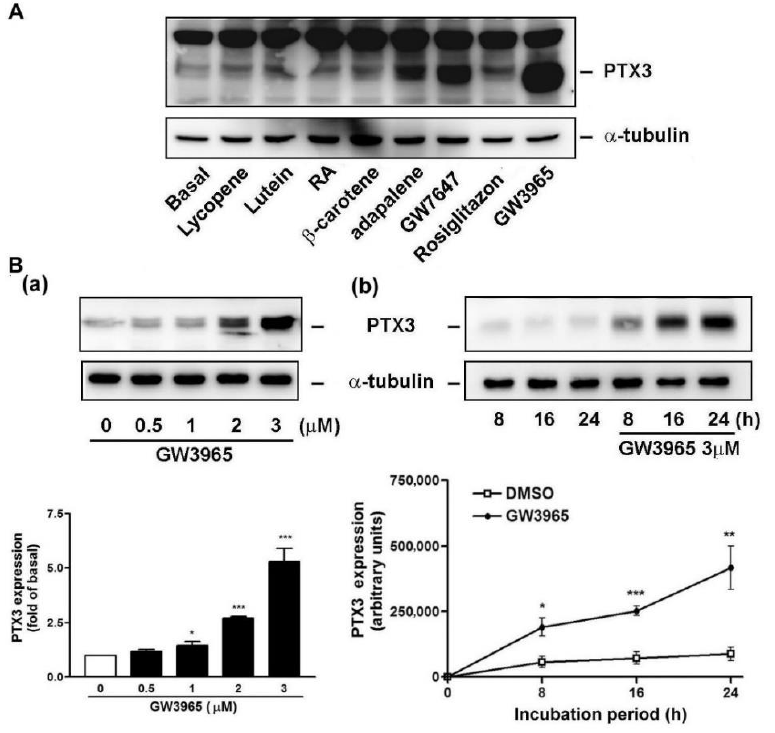
Figure 3. GW3965 induces PTX3 protein expression. ( A ) Effect of the nuclear receptor (NR) agonists on PTX3 expression. The fibroblasts were incubated with the NR-related compounds: carotenoids (lycopene, lutein, and β-carotene, 5 μM), retinoids (retinoic acid; RA, 1 μM and adapalene, RAR β/γ agonist, 2 μM), LXR agonist (GW3965, 5 μM), and PPAR agonists (GW7647, a PPARα agonist, 10 μM and rosiglitazone, PPARγ agonist, 30 μM). ( B ) GW3965 induced PTX3 protein expression. The fibroblasts were treated with ( a ) the GW3965 doses for 16 h or ( b ) GW3965 for the time periods and then analyzed by Western blot and densitometric analysis ( n = 4). Pentraxin-3 (PTX-3), retinoic acid (RA), and dimethyl sulfoxide (DMSO). * p < 0.05, ** p < 0.01, and *** p < 0.001 versus control (DMSO).